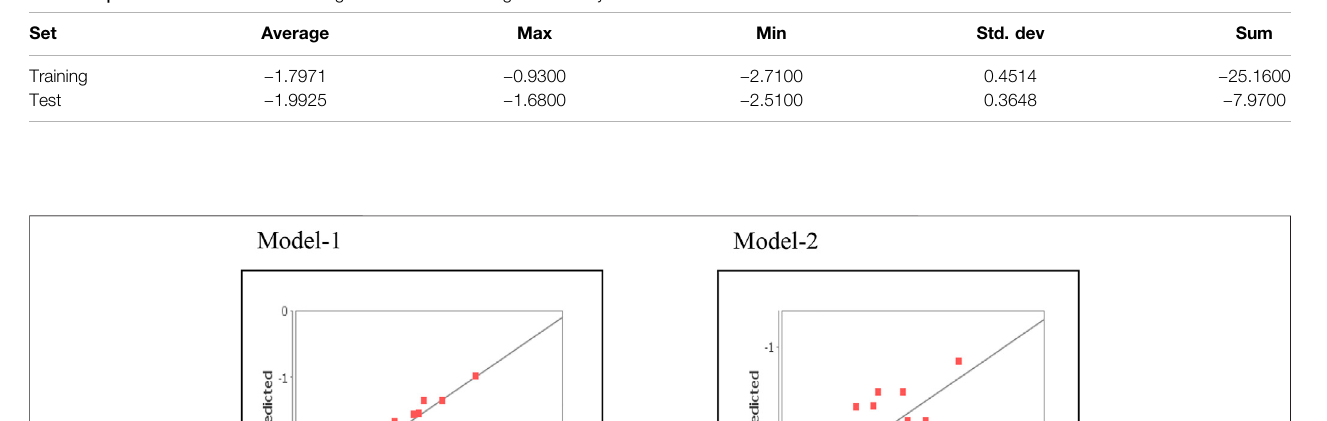
TABLE 2 | Unicolumn statistics of training and test sets for fungicidal